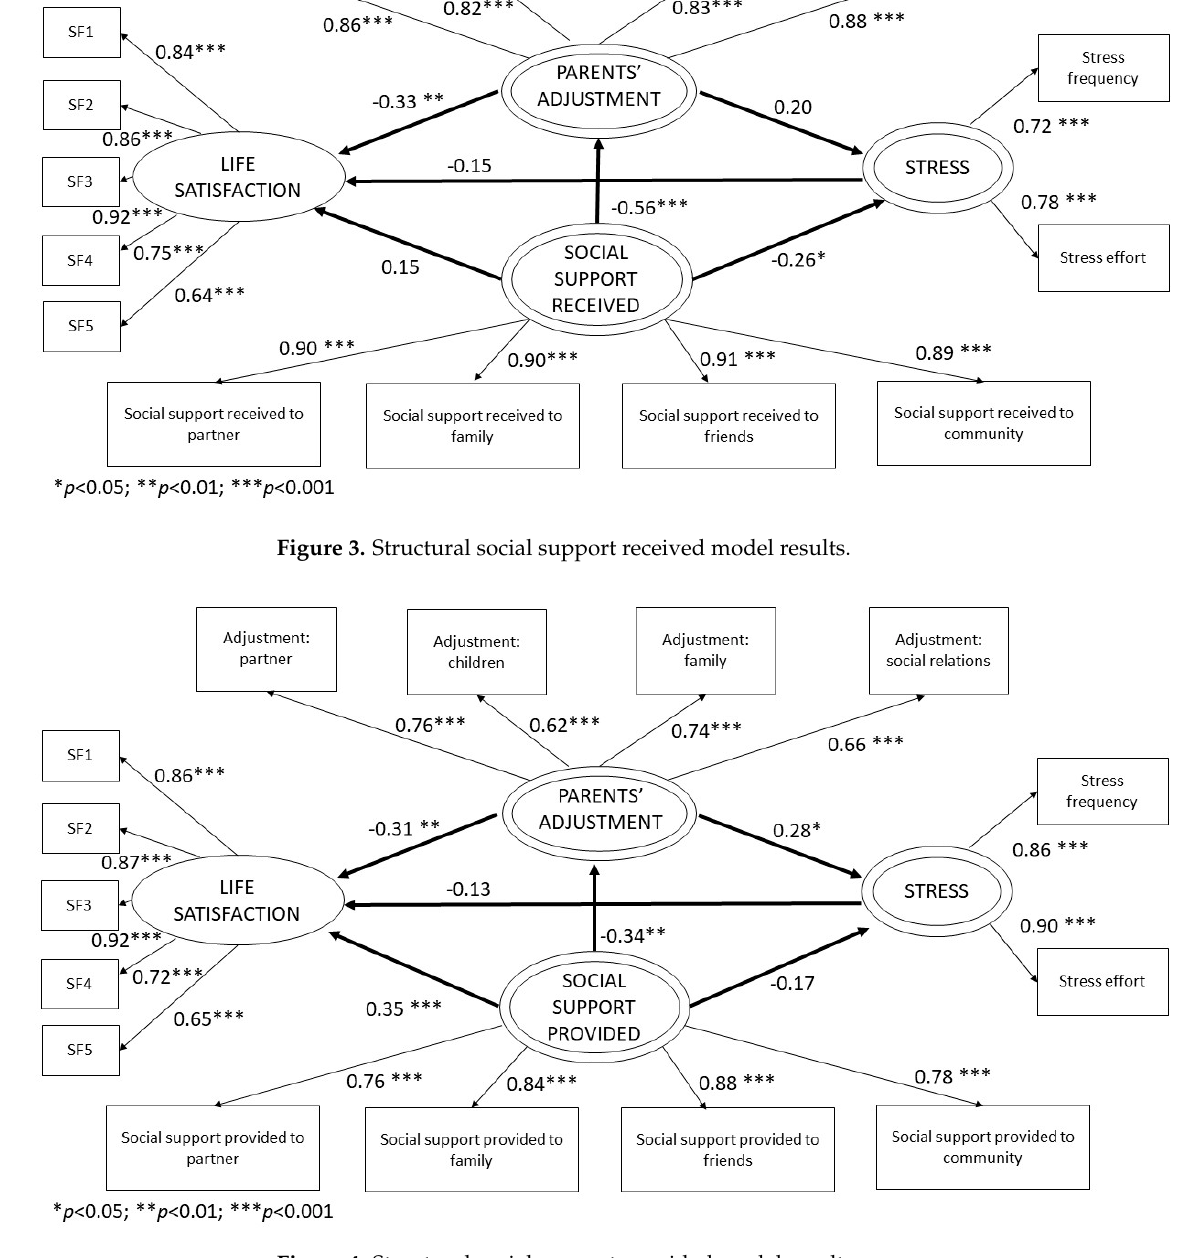
Figure 4. Structural social support provided model results. Table 3. Path coefficient, effect size, magnitude, and significance of the structural social support received model paths.